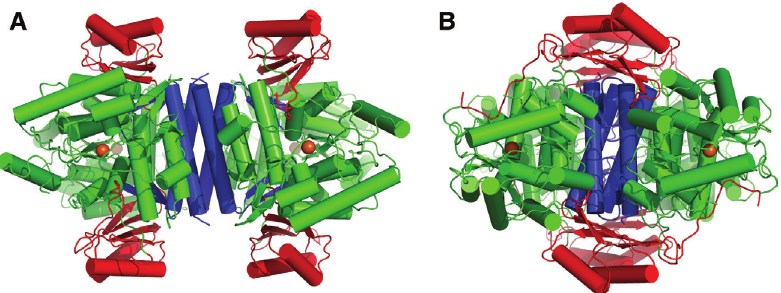
Figure 1 Visualizations of the tetrameric state of PAH based on a model of Jaffe et al. [12]: PAH is shown in cartoon representation with the catalytic iron ions as brown spheres. The regulatory domain is colored in red, the catalytic domain in green, and the oligomerization domain in blue. (B) Shows a rotation of (A) by 90 ° around the y-axis. The red N-terminal regulatory domains restrict the access to the catalytic sites